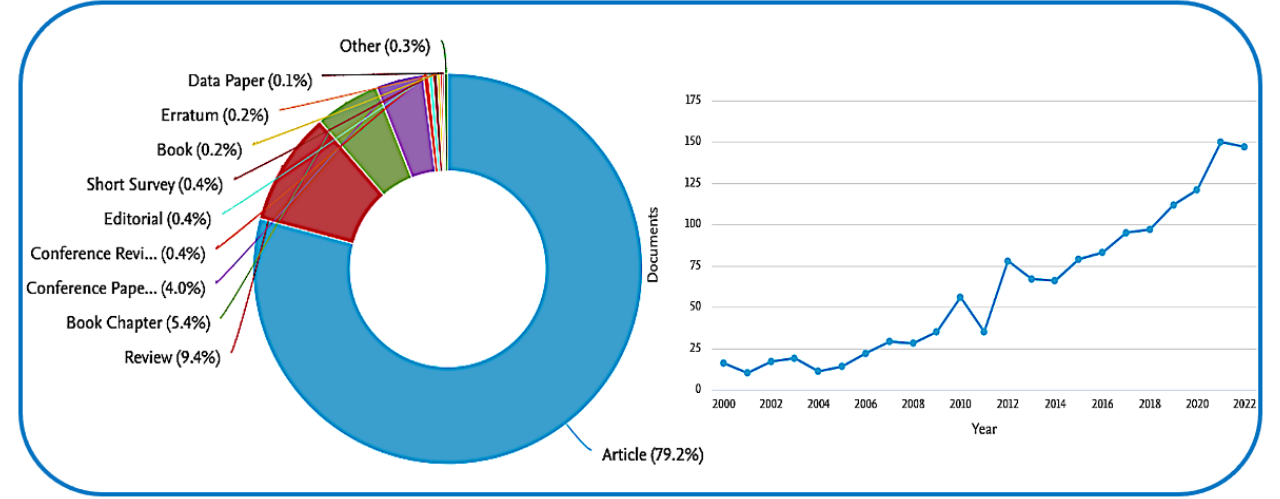
Figure 1. The trend in the number of publications related to marine collagen indexed on Scopus, from 2000 to 2022 (last accessed 29 December 2022 https://www.scopus.com/term/analyzer.uri?sid=8346601bf23e38fdb98df3827ad94193&origin=resultslist&src=s&s=ALL%28marine+collagene%29+AND+PUBYEAR+%3e+1999&sort=plf-f&sdt=b&sot=b&sl=40&count=262&analyzeResults=Analyze+results&txGid=d83dade43155068dbf08353305d81e52) .